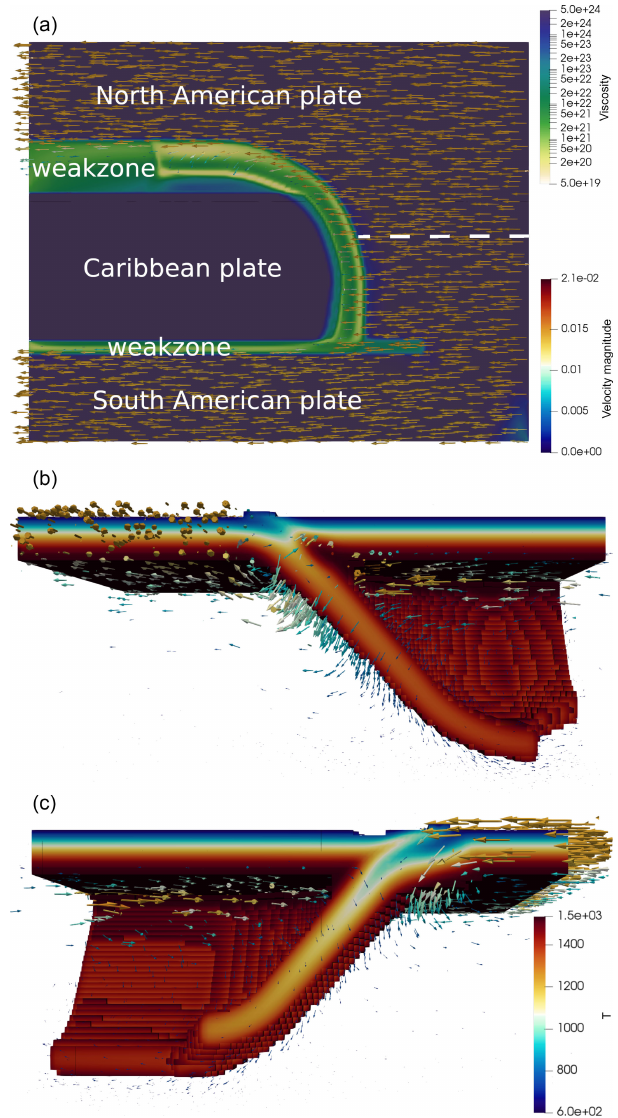
Figure 9. The 3-D ASPECT Caribbean example after 2.5million years of evolution. The top image is a top view of the model where the top 50km section is removed and where the viscosity field is shown with the velocity field indicated by the arrows. The bottom two figures are cutouts of the temperature field between 600 and 1535K, showing in color the temperature ( T ), and with arrows the velocity fields, highlighting the velocity field in the slab and litho-